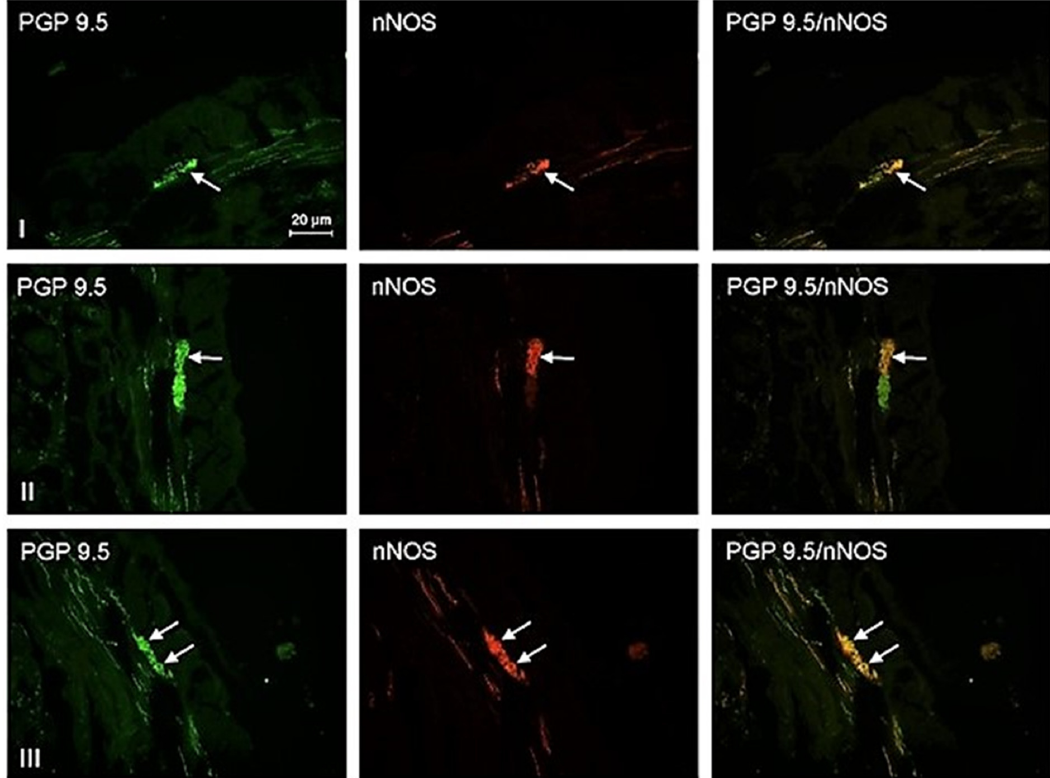
Figure 1. Myenteric neuronal cells in the descending colon immunoreactive to nNOS and PGP 9.5 (indicated with arrows) in the control ( I ), sham operated ( II ), and animals with chemically-induced inflammation ( III ).